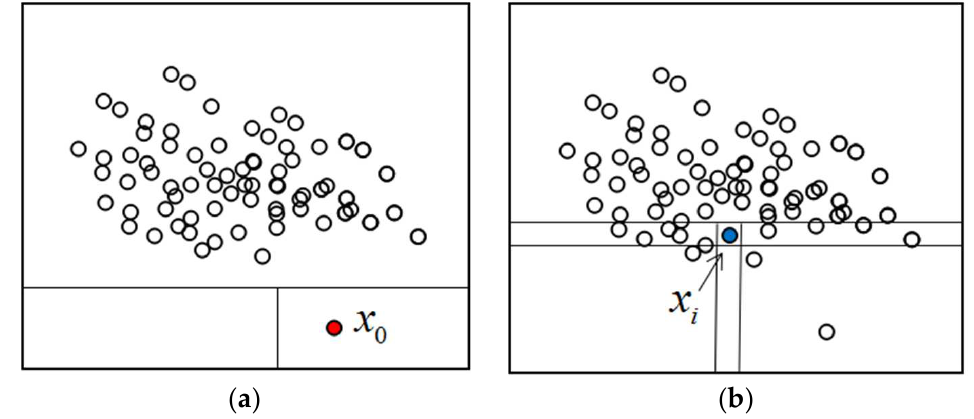
Figure 2. Diagram of the splitting point. ( a ) Anomaly splitting; ( b ) Normal point splitting.